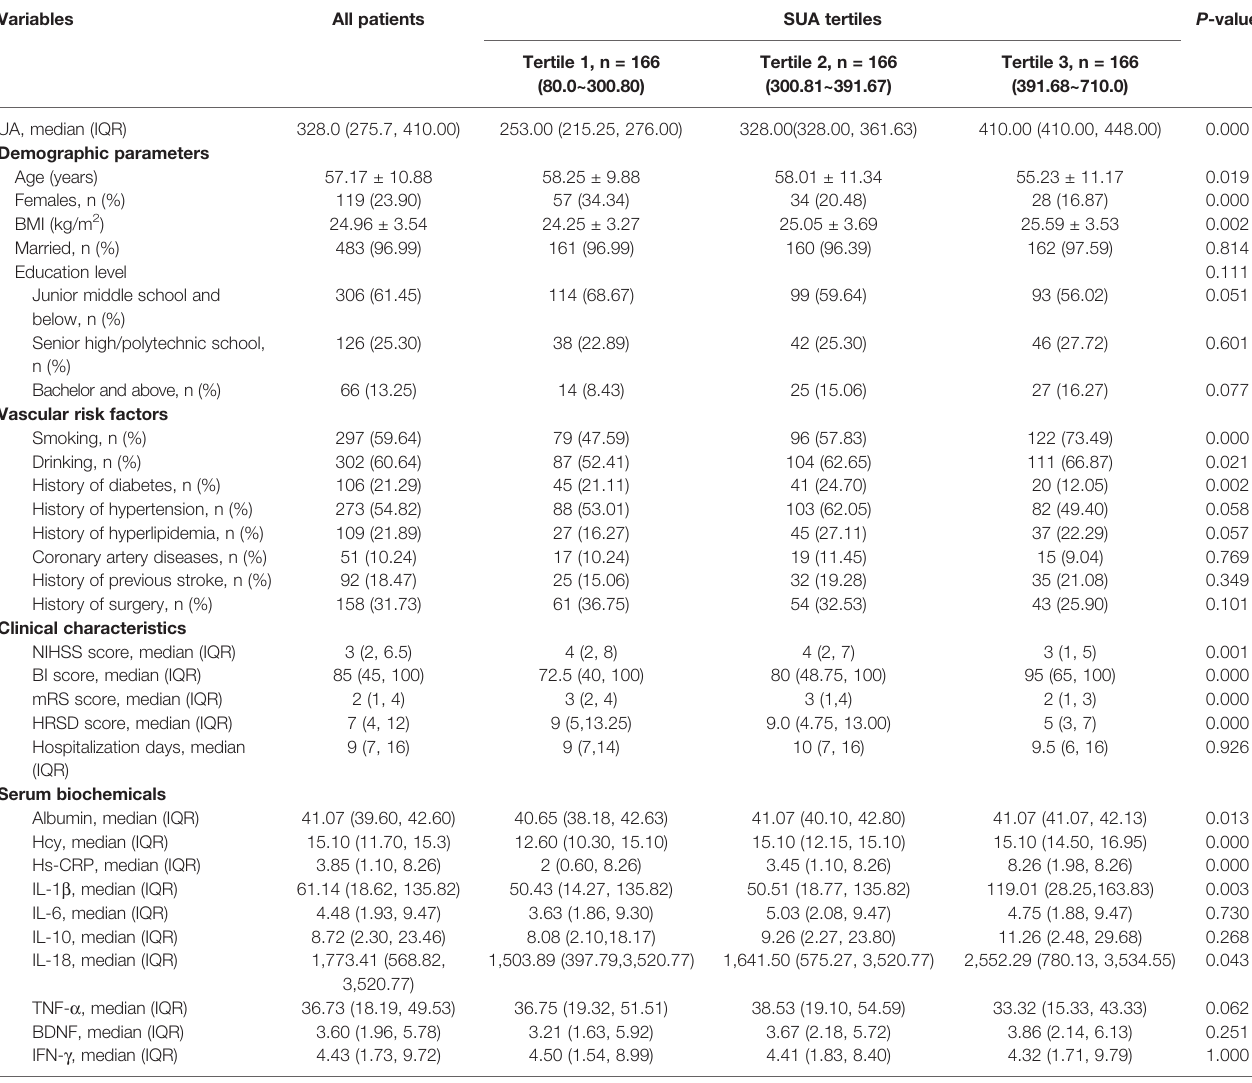
TABLE 1 | Baseline characteristics of patients with stroke according to SUA tertiles. Variables All